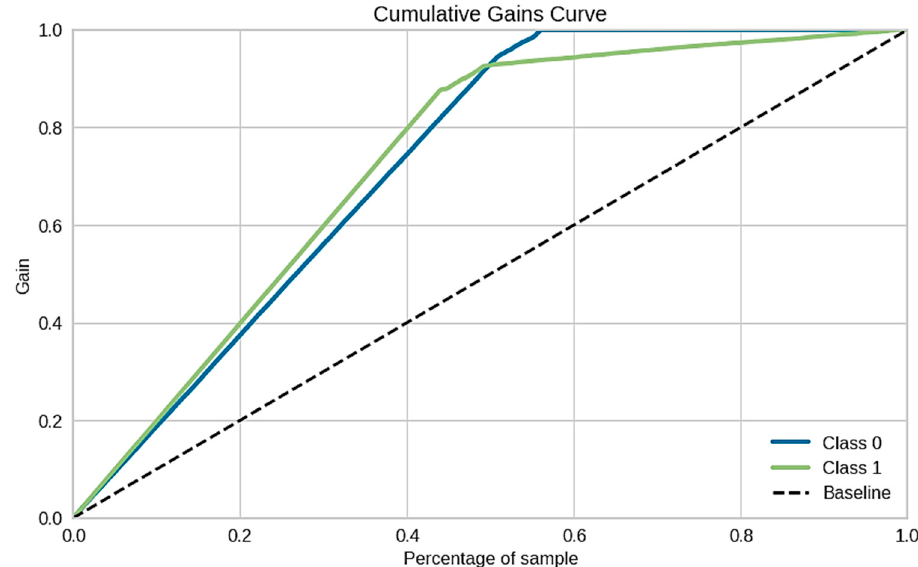
Figure 14. Cumulative gains curve of NGBoost classification algorithm.